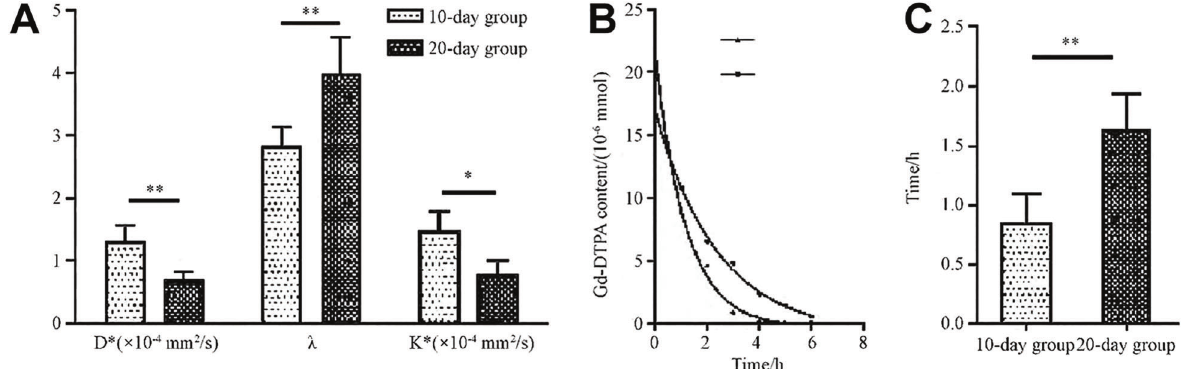
Figure 3. Diffusion parameters and half-life of gadolinium-diethylenetriamine pentaacetic acid (Gd-DTPA) in 10-day (n=8) and 20-day (n=8) gliomas. A , Quantitative analyses of diffusion parameters (D*, l , K). B , Amounts of remnant Gd-DTPA in gliomas following an exponential decay. C , Statistical analysis of the half-life. Data are reported as means ± SD (n=8). *P o 0.05; **P o 0.01 ( t -test). D*: effective diffusion coef fi cient; l : tortuosity; K: elimination rate constant.